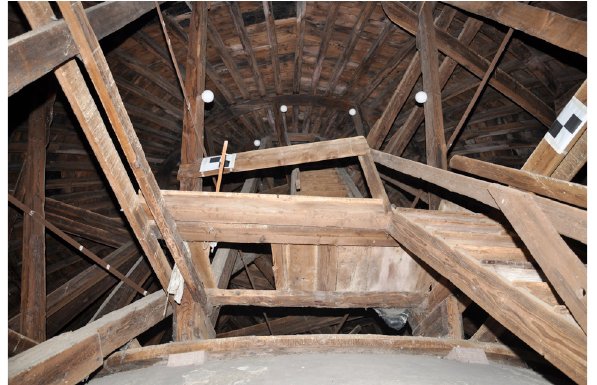
Figure 3. The wooden structure of the dome and of the staircase that takes people up to the